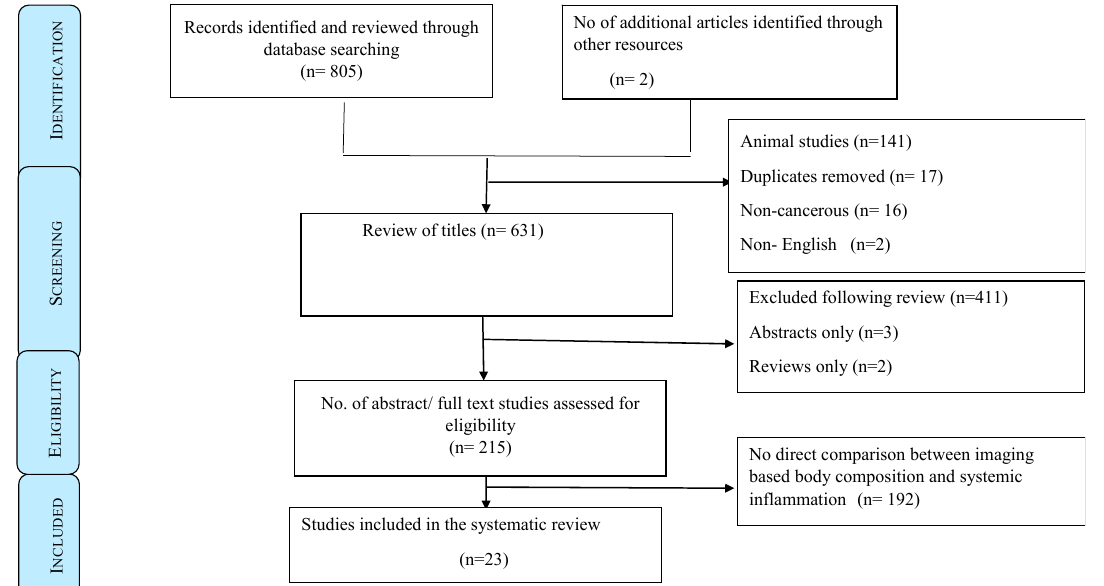
Figure 1. Preferred reporting items for systematic review protocol flow diagram.